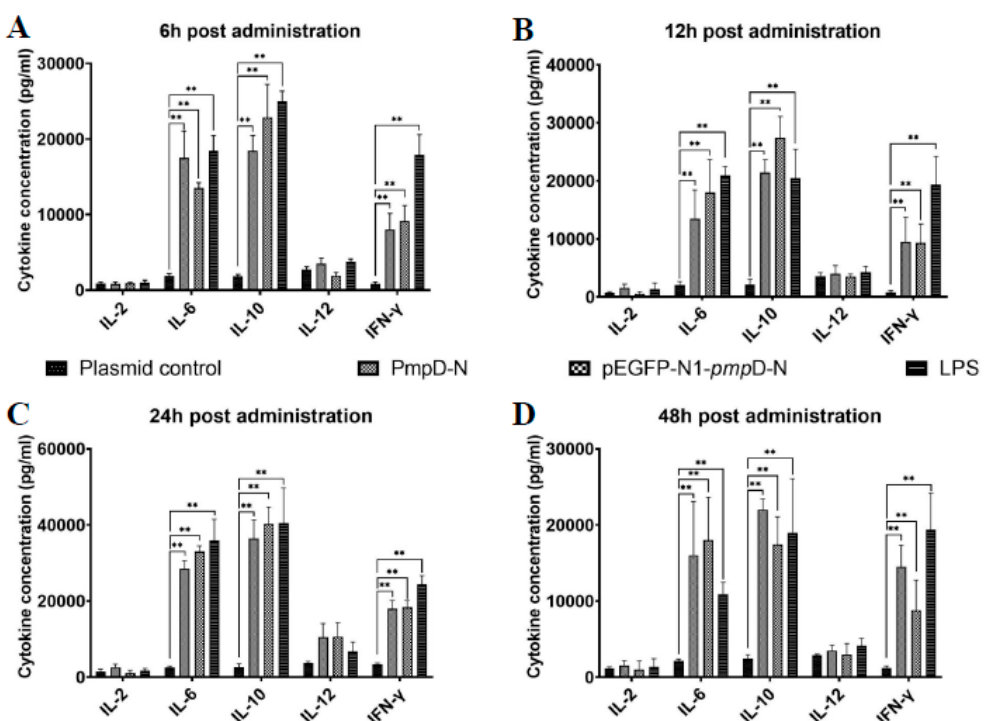
Figure 3. Cytokine secretions post-treatment with PmpD-N or pEGFP-N1-pmpD-N. At indicated time points after infection, the levels of cytokines (interleukin (IL)-2, IL-6, IL-10, IL-12, and IFN- γ ) secreted were measured using chicken cytokine ELISA kits ( A ) 6h; ( B ).12h; ( C ).24h; ( D ).48h. Statistical analyses were performed with one-way analysis of variance (ANOVA) with Tukey’s post hoc multiple comparisons test (** p < 0.01 when compared with the plasmid control group, * p < 0.05 when compared with the plasmid control group).